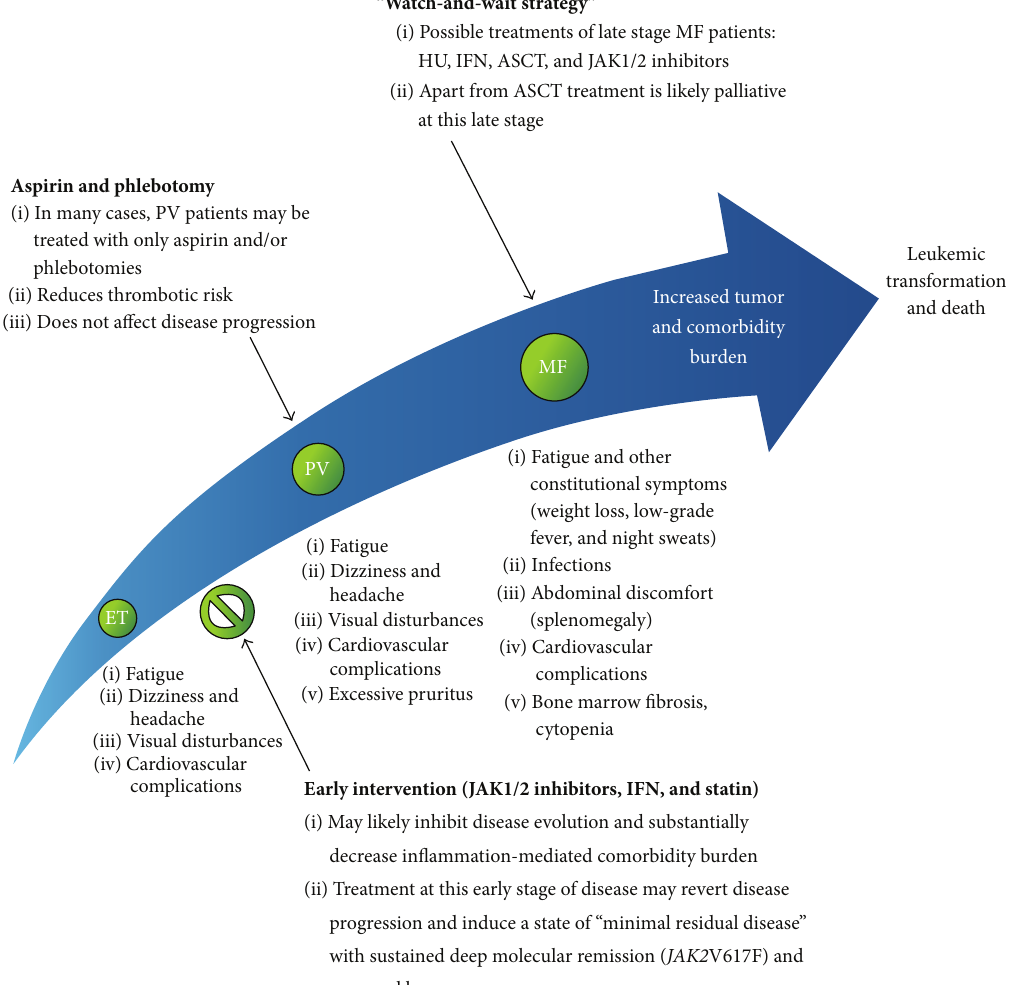
Figure 6: The MPNs care pathway and the effect of early intervention. It is suggested that ET, PV, and MF form a biological continuum and, thus, early intervention with combination therapies including JAK1/2 inhibitors, IFN, and/or statins is likely to result in the inhibition of disease evolution. ASCT: allogeneic stem cell transplantation; ET: essential thrombocythemia; HU: hydroxyurea; IFN: interferon; JAK: Janus kinase; MF: myelofibrosis; and PV: polycythemia vera (with permission: H. C. Hasselbalch